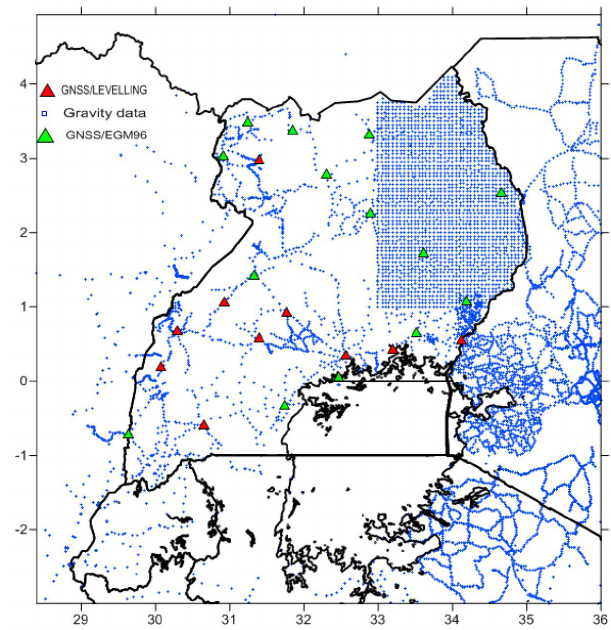
Figure 1: Location of the gravity data and